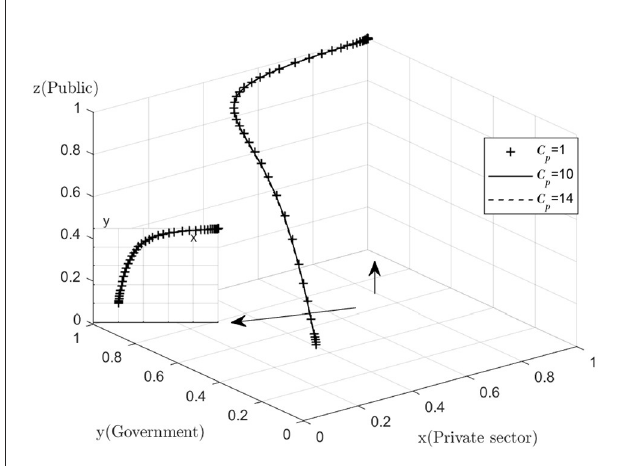
FIGURE8 Impact of active monitoring costs.